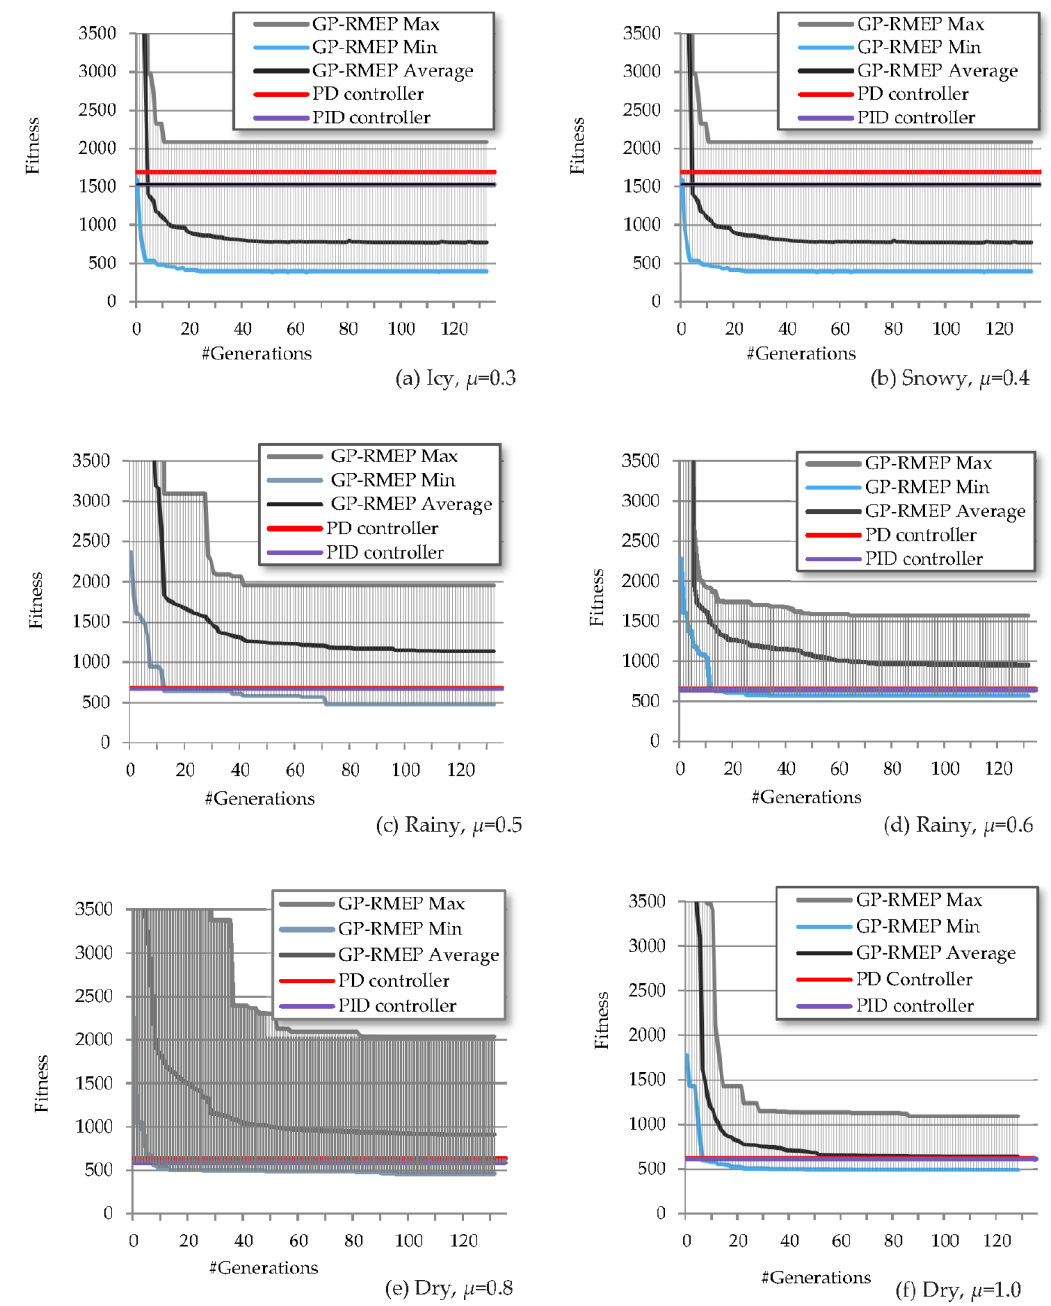
Figure 7. Fitness convergence characteristics for 20 independent runs of GP evolving the SAF of the GP-RMEP controller for friction coefficients µ = 0.3 ( a ), µ = 0.4 ( b ), µ = 0.5 ( c ), µ = 0.6 ( d ), µ = 0.8 ( e ), and µ = 1.0 ( f ), respectively. The bold curves correspond to the mean, while the envelope shows the minimum and maximum values in each generation. The best fitness of the PD and PID controllers (obtained via a complete enumeration of the values of their parameters) are shown as horizontal lines.